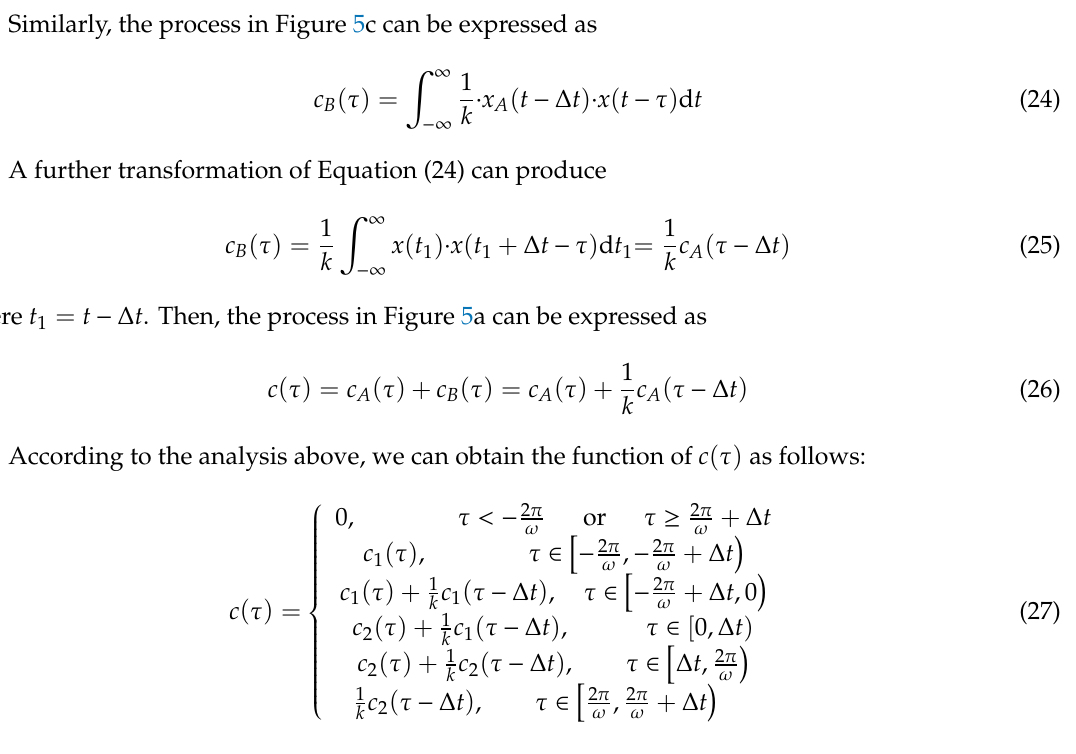
Figure 5. Cross-correlation algorithm; ( a ) the process of cross-correlation ( CC) for a two-debris aliasing signal (left) and its result (right); ( b ) the process of CC for Debris A’s signal and its result; ( c ) the process of CC for Debris B’s signal and its